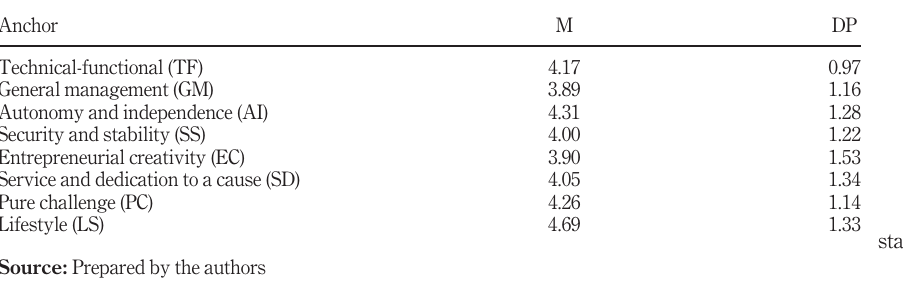
Table 2. Averages